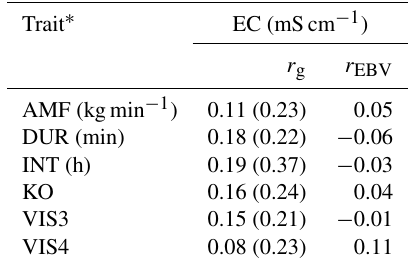
Table 7. Genetic correlations ( r g ) with standard errors (in brackets) and breeding value correlations ( r EBV ) considering bulls with at least five daughters between behavior indicator traits and electrical conductivity of the udder